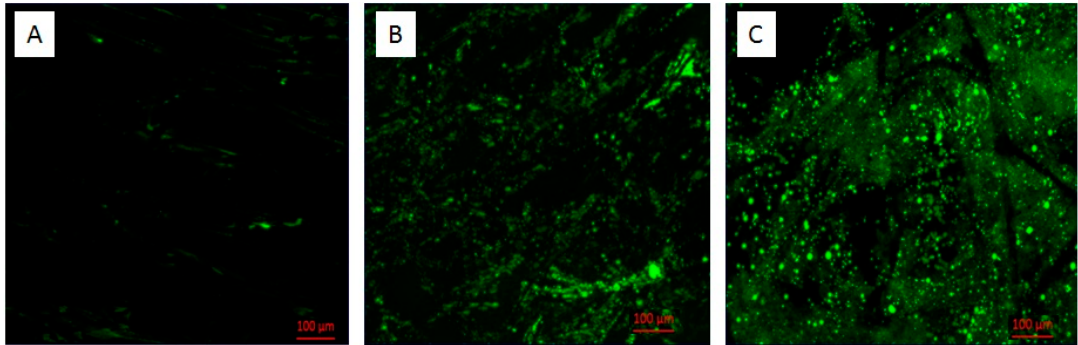
Figure 6. Epifluorescence microscopy images of cross sectioned anodes formed on carbon felt ( A ), LTA zeolite-modified anodes ( B ), and bentonite-modified anodes ( C ).